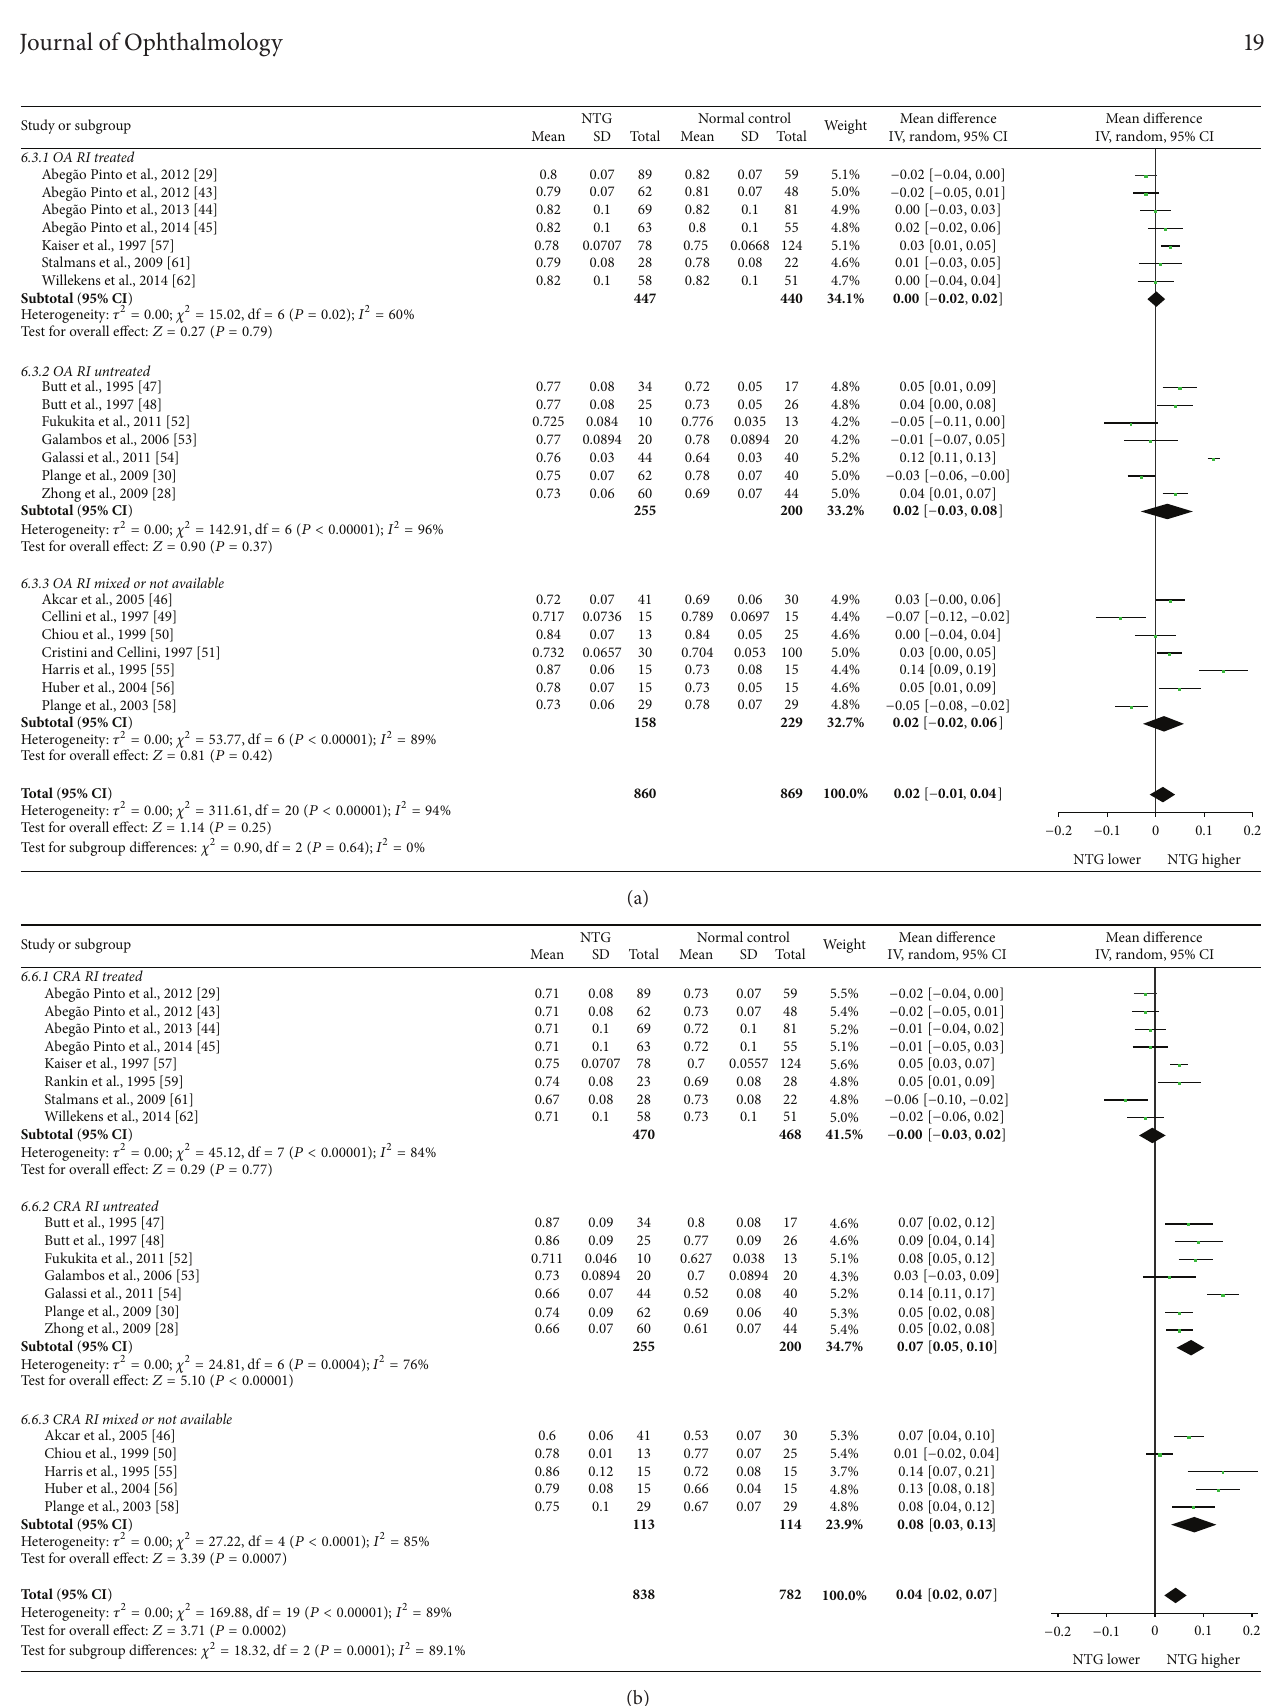
Figure 8: Forest plot of RI in OA and